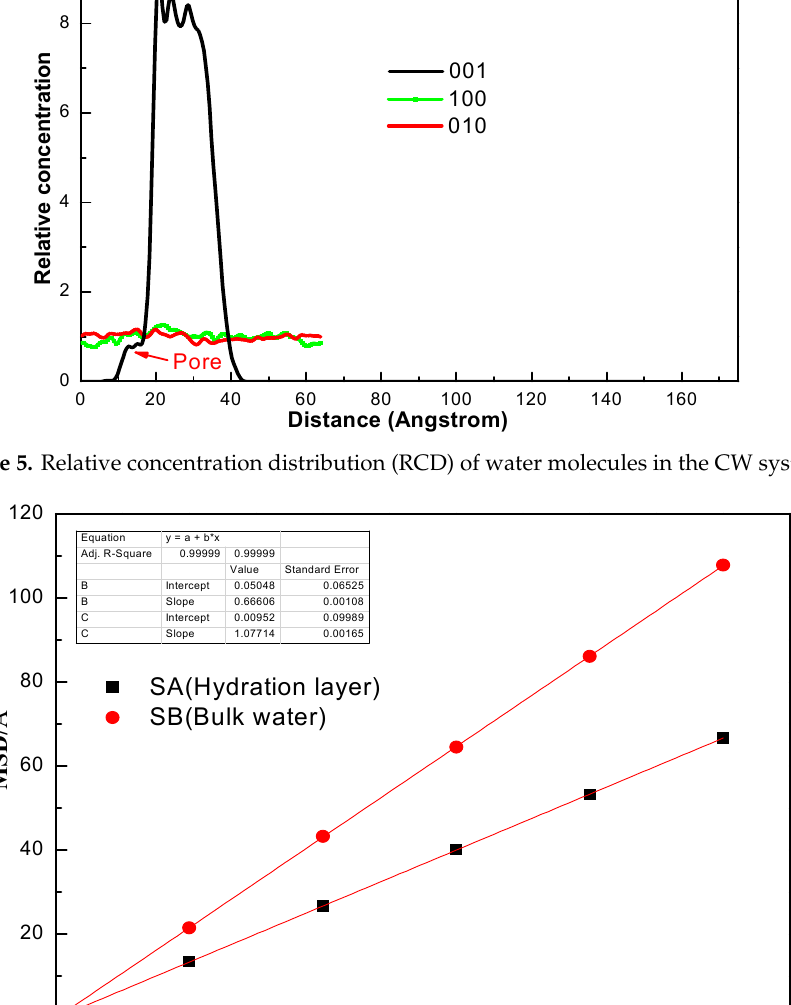
Figure 6. Mean square displacement (MSD) of water molecules in SA (hydration layer) and SB (bulk water).